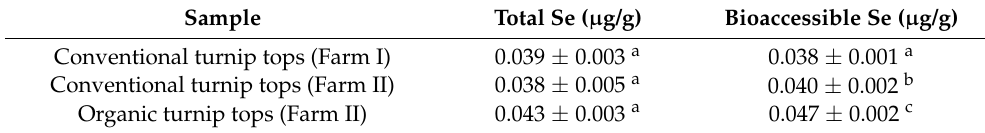
Table 5. Se total and bioaccessible ( µ g/g dry weight) in turnip tops (mean ± standard deviation). Sample Total Se ( µ g/g) Bioaccessible Se ( µ